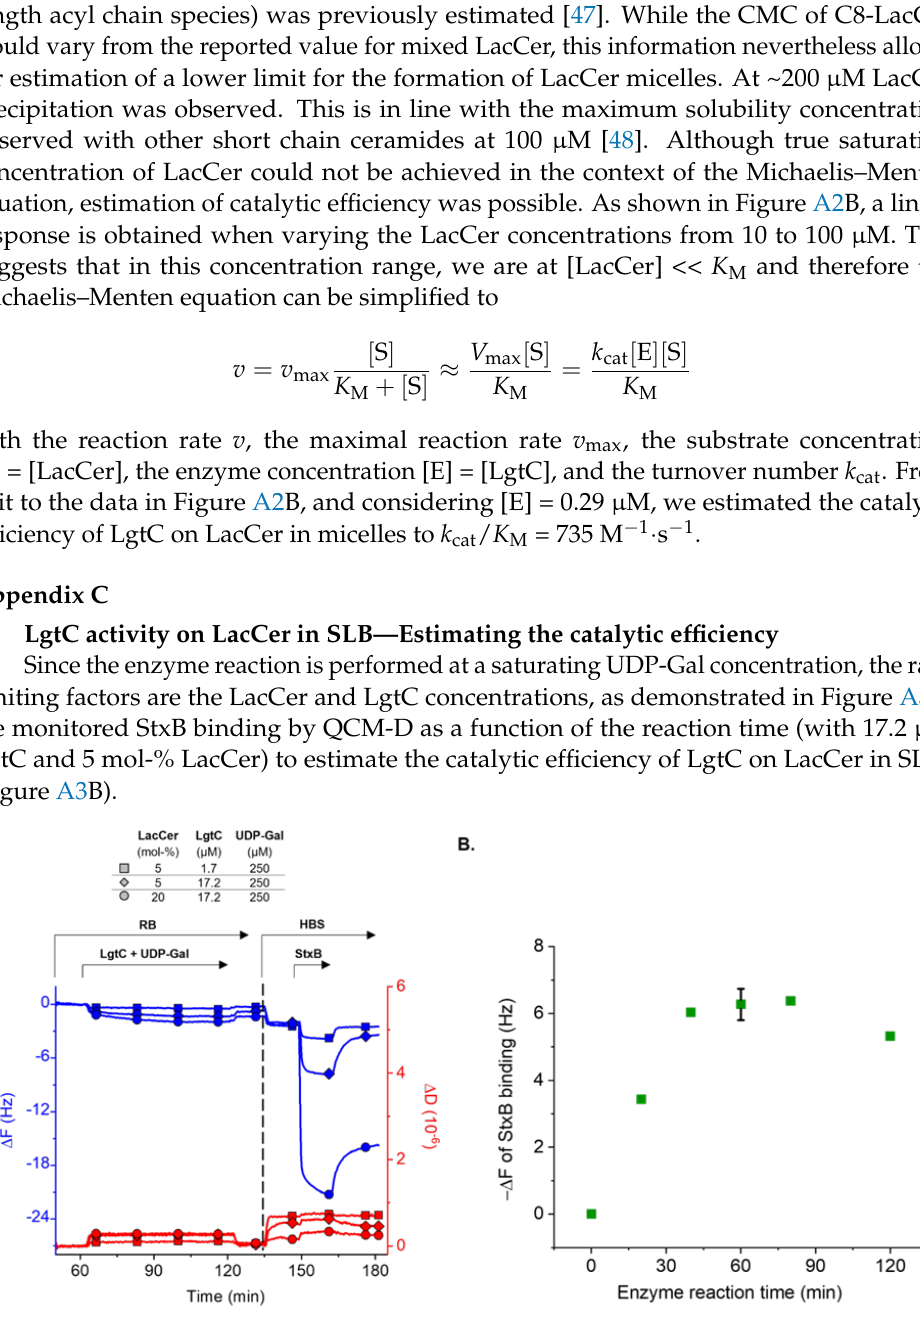
Figure A3. Parameters determining the reaction rate. ( A ) Representative QCM-D data of the enzyme reaction under different conditions (lines with symbols as indicated), and subsequent reporting of Gb3 by StxB binding. The net frequency changes ( Δ F ) after the enzyme reaction step were minor, ranging from − 0.3 Hz (5 mol-% LacCer, 1.72 μ M LgtC) to − 0.8 Hz (5 mol-% LacCer, 17.2 μ M LgtC) to − 1.0 Hz (20 mol-% LacCer, 17.2 μ M LgtC), and the net dissipation shifts ( Δ D ) were also small. The frequency shifts at equilibrium for StxB binding were − 1.5 Hz, − 5.8 Hz and − 18.8 Hz, respectively. ( B ) Plot of −Δ F for equilibrium StxB binding (at 6.5 μ M StxB; a measure of the Gb3 content in the SLB) vs. enzyme reaction time. Conditions: 5 mol-% LacCer, 17.2 μ M LgtC and 0.25 mM UDP-Gal. The reaction is complete within approximately 60 min, leading to −Δ F = 6.5 ± 0.5 Hz ( n = 3). Half maximum −Δ F is approximated to be at 20 min.